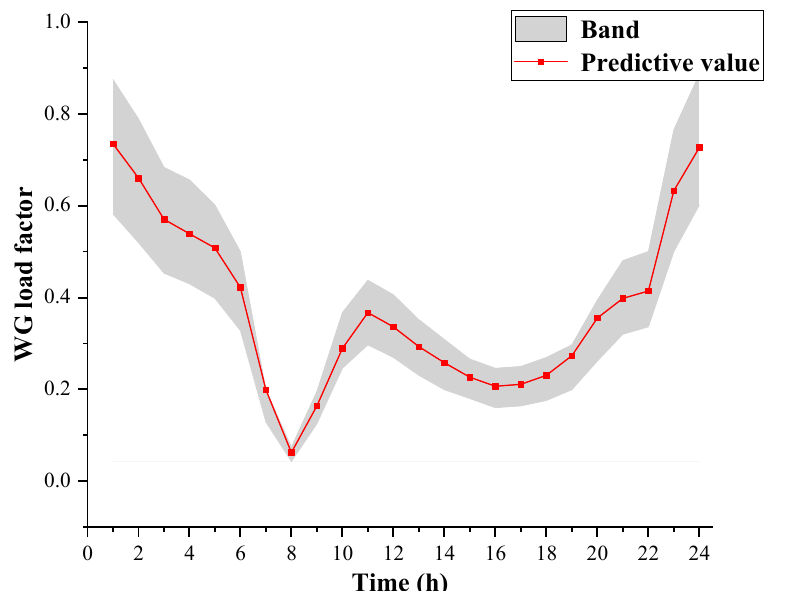
Figure 6. Forecast curve of WG output.